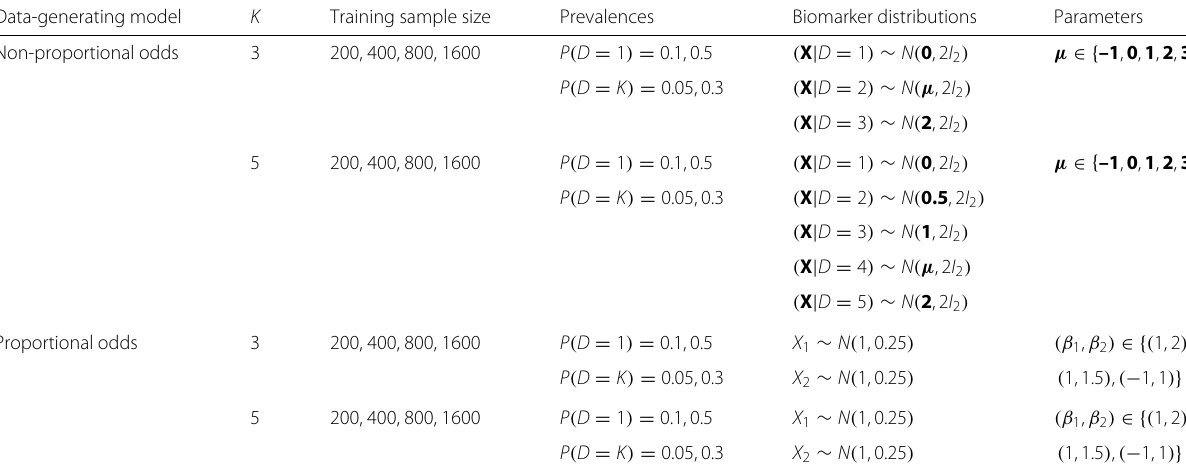
Table 1 Description of simulation scenarios for combination construction Data-generating model K Training sample size Prevalences Biomarker distributions Parameters Non-proportional